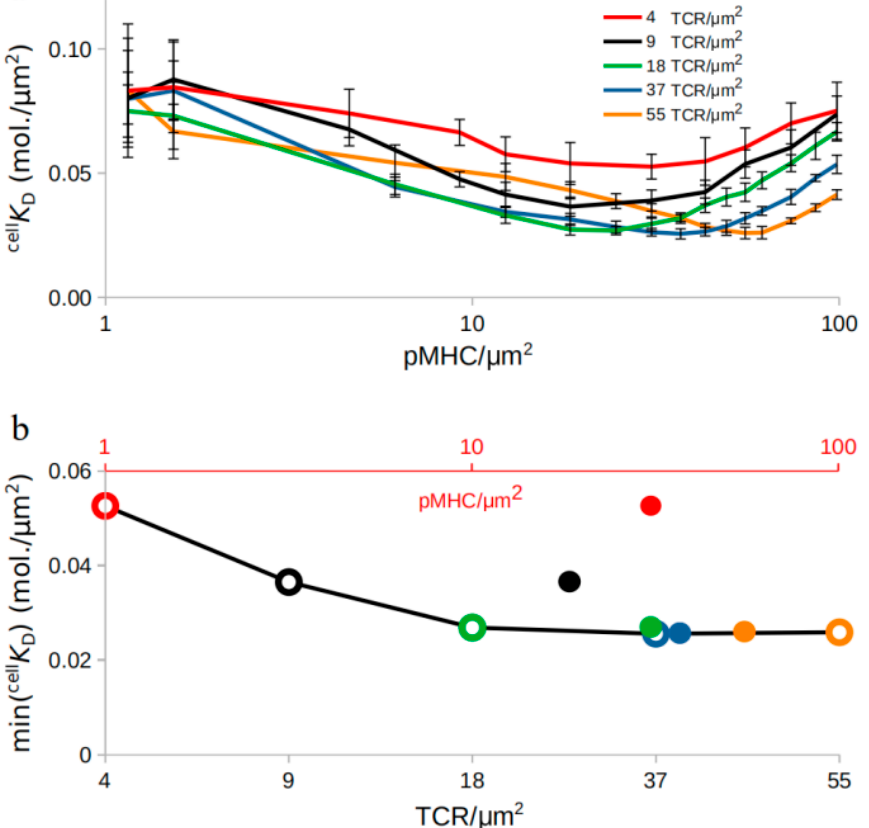
Figure 2. Affinity modulation during TCR amount titration: ( a ) the in situ dissociation rate, cell K D , changes for TCR amount titration. ( b ) Minimum cell K D values for each TCR density (grey x -axis; circles) during TCR amount titration and pMHC density (red x -axis; dots) for which the minimum cell K D values are achieved: Error bars represent SD of n = 10 simulations.